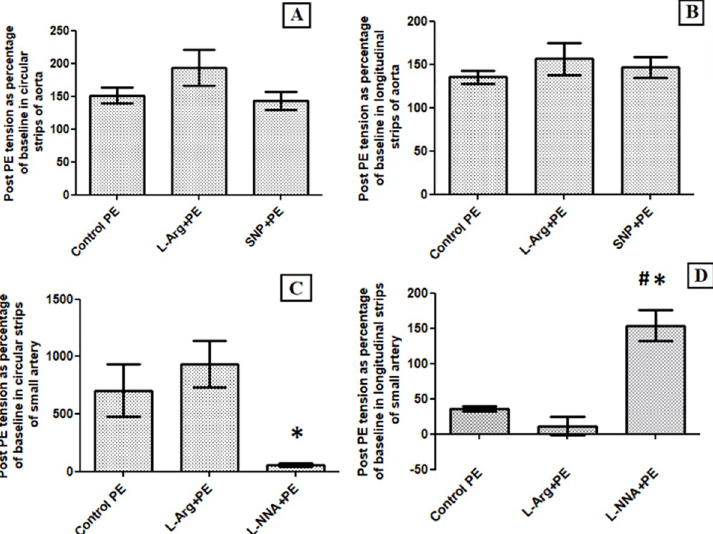
Fig 6. Bar diagrams representing tension after PE administration as a percentage of baseline tension (A) Circular Strip preparation of aorta, (B) Longitudinal strip preparation of aorta, (C) Transverse cylinder preparation of small artery and (D) Longitudinal strip preparation of small artery. There was no significant difference between the contractile responses to PE in the presence or absence of L-Arginine (P value = 0.273 with MWU) as well as SNP (P value = 0.754 with MWU) in circular and longitudinal strips of aorta. There was no significant difference in percentage change in tension due to PE in the presence or absence of L-Arginine in transverse cylinder preparation (P value = 0.273, MWU test) and longitudinal strip preparation of small artery (P value = 0.08, MWU test). In panel C, lack of contractile response of circular strips of small artery to PE (Post PE tension around 100% of baseline tension) in presence of L-NNA was statistically significant as compared to effect of PE alone ( � ). In panel D, the last bar represents contractile response to L-NNA itself, while there was no further increase in tension with addition of PE. Lack of relaxant response to PE was significant as compared to effect of PE alone.